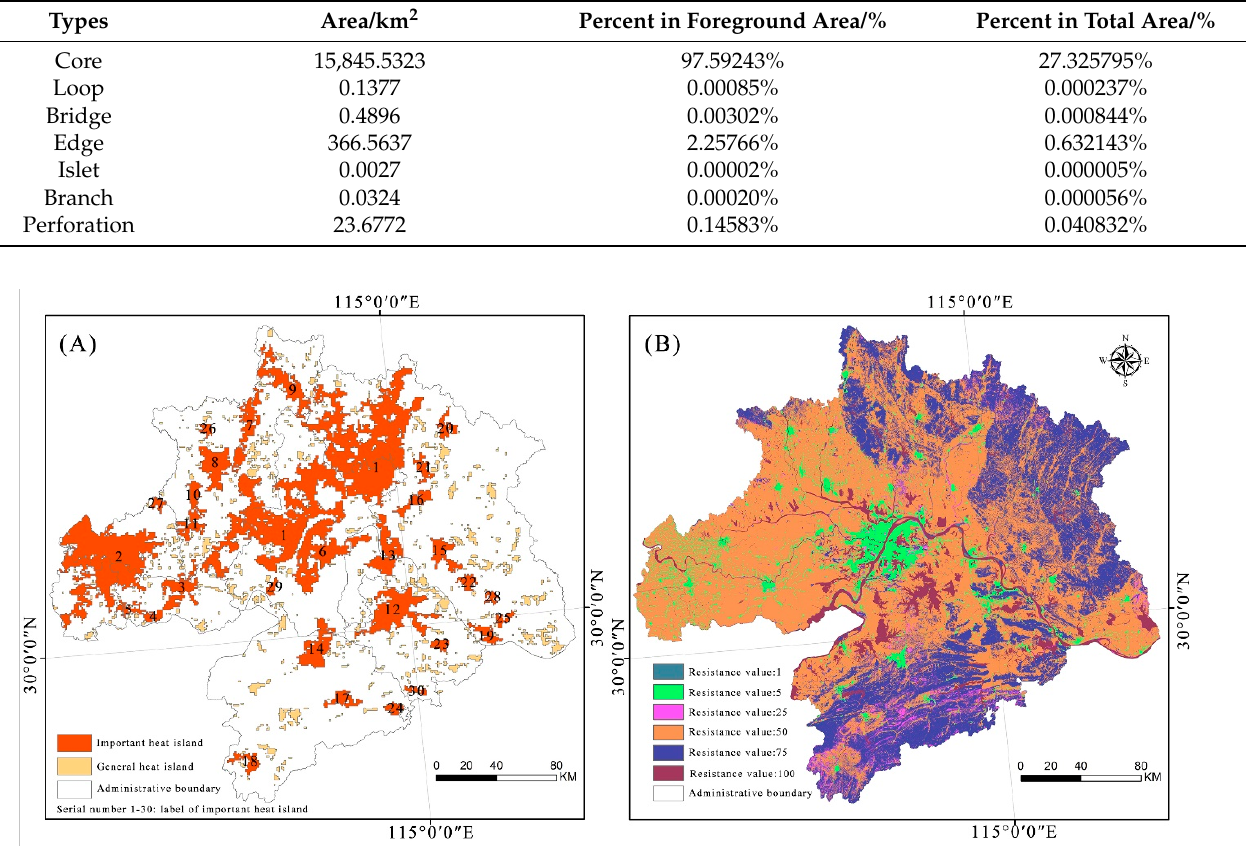
Table 2. MSPA classification statistics.